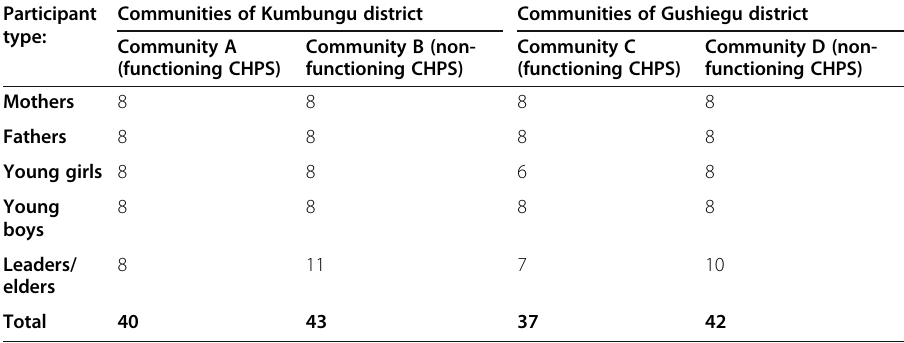
Table 1 Number of participants distributed across the five groups by community Participant